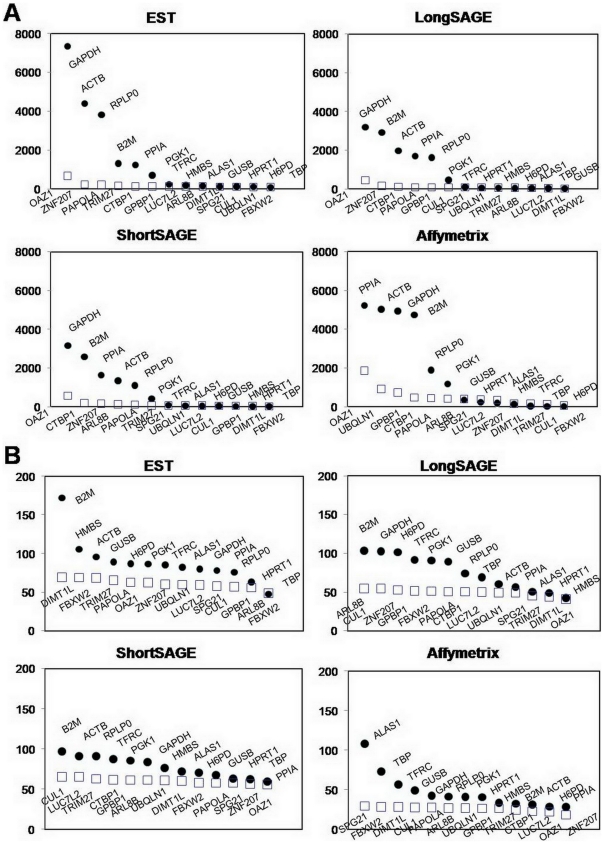
Comparison of gene expression and CV between nERGs and tERGs in each dataset.(A) Comparison of gene expression between 13 nERGs and 13 tERGs. (B) Comparison of CV between 13 nERGs and 13 tERGs. Empty squares represent nERGs identified in this study and circles represent the tERGs.